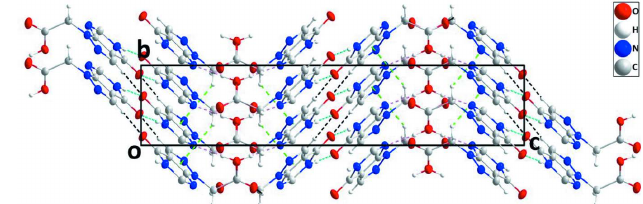
Figure 3 View of the crystal packing along the a- axis direction with N—H (cid:2)(cid:2)(cid:2) O, O—H (cid:2)(cid:2)(cid:2) N and C—H (cid:2)(cid:2)(cid:2) O hydrogen bonds shown, respectively, by light- blue, pink and black dashed lines. C—H (cid:2)(cid:2)(cid:2) (cid:2) (ring) interactions are shown by green dashed lines.